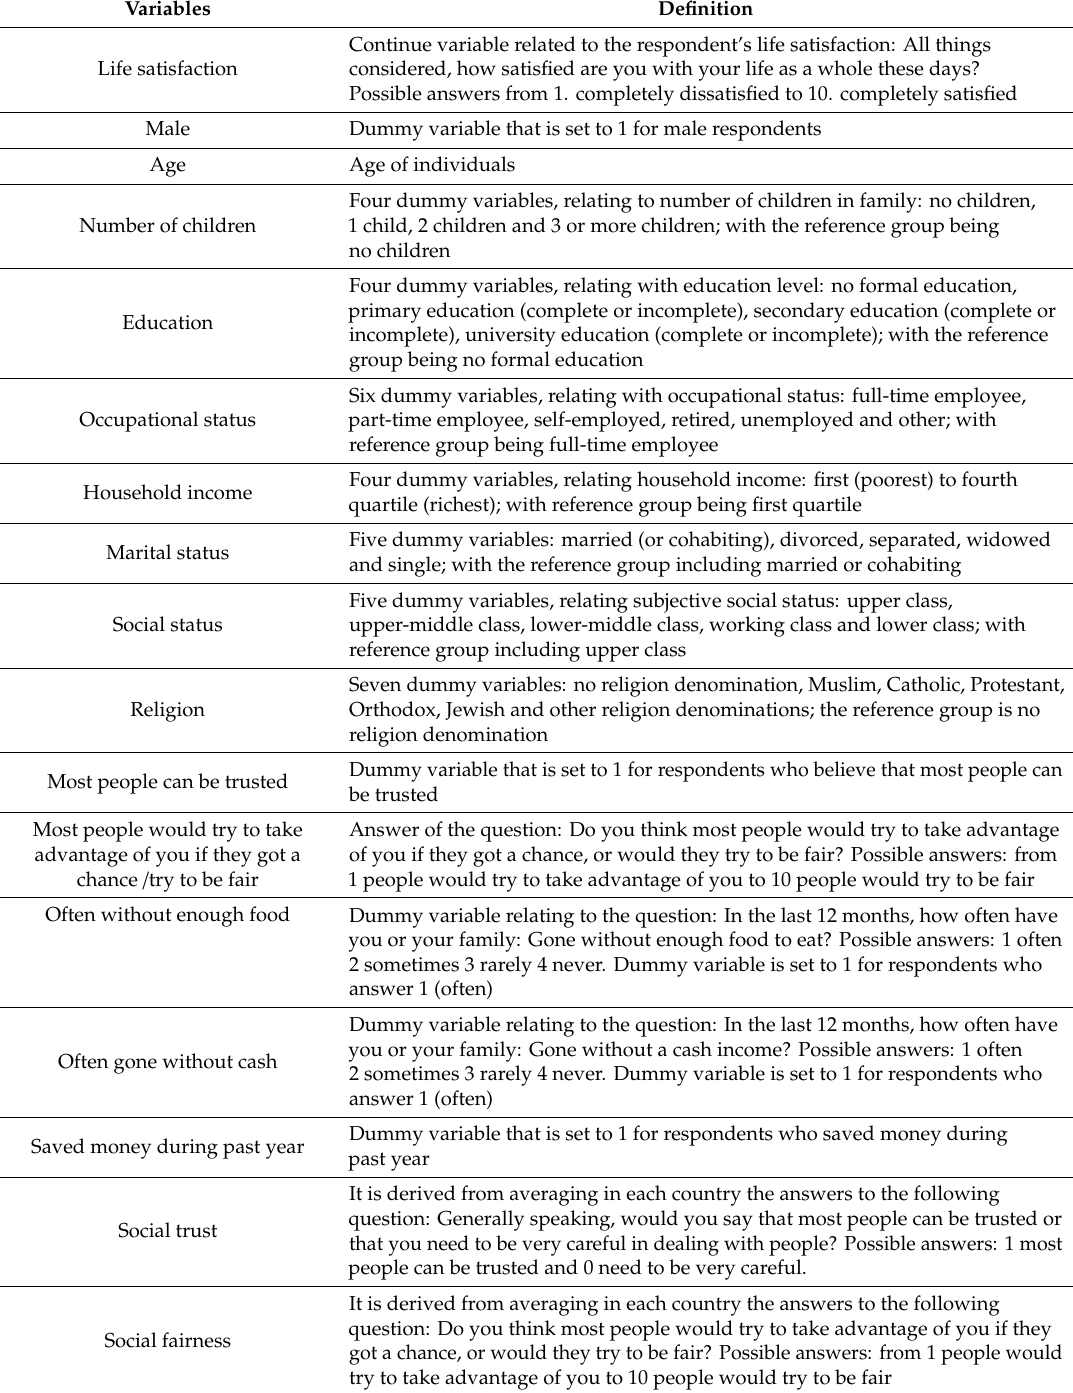
Table A4. Definition of